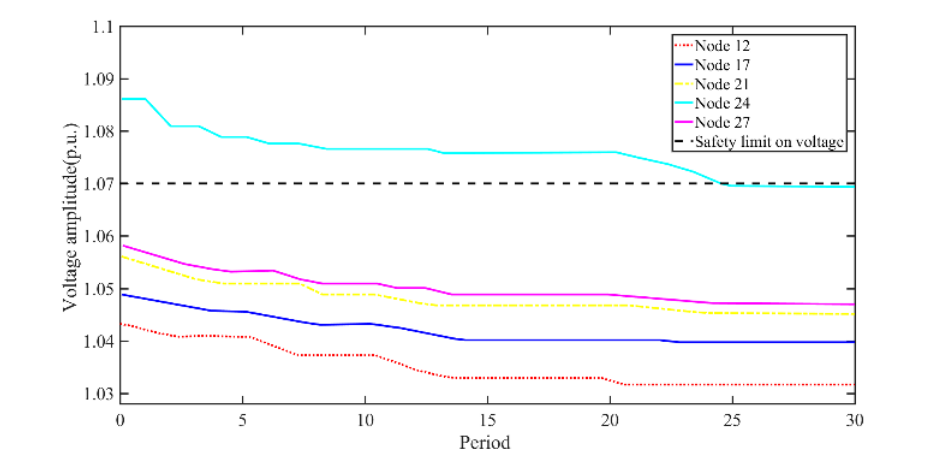
Fig. 8. Voltage change graph of DPV node in area